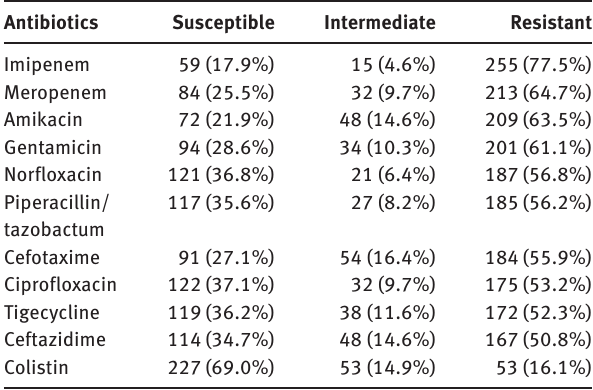
Table 3: Antibiotic susceptibility testing.